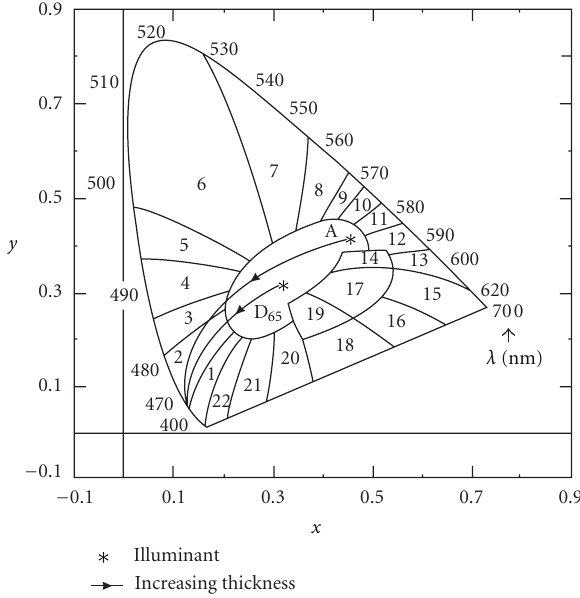
Figure 3: 1931 2 ◦ CIE Chromaticity Diagram containing the A and D 65 sources and topaz color line path depending on thickness.